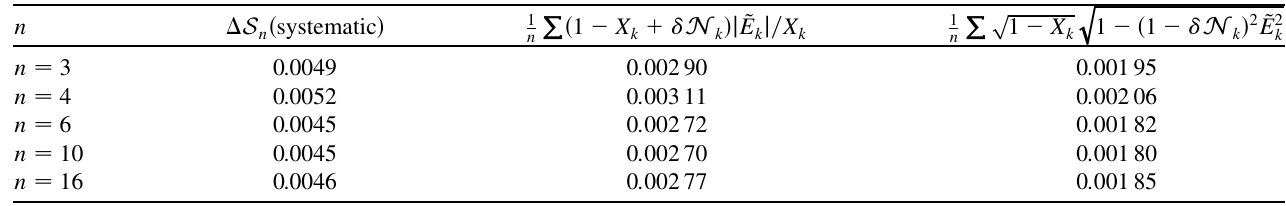
P ffiffiffiffiffiffiffiffiffiffiffiffiffiffiffi p 1 (cid:2) X k n